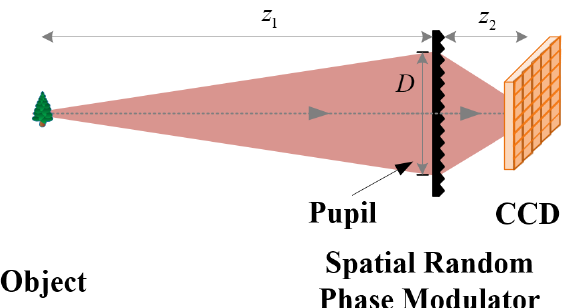
Figure 8. Schematic of a lensless Wiener-Khinchin telescope based on high-order spatial autocorrelation of thermal light